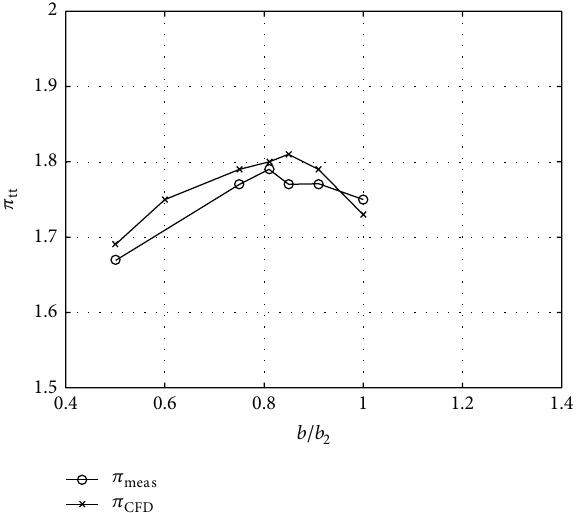
Figure8:Comparisonbetweenmeasuredandsimulatedstagetotal- to-total pressure ratios. The pressure ratio for each design is taken at the same mass flow.